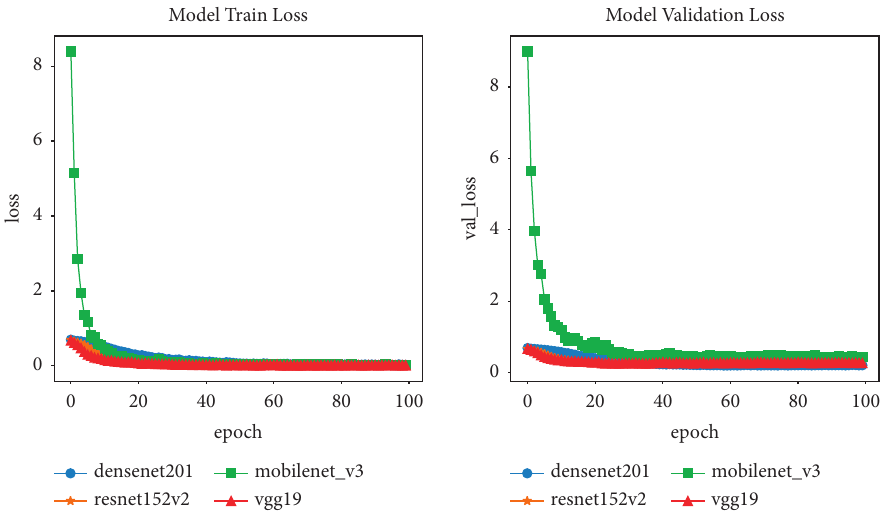
Figure 11: Loss of network architectures after data normalization.